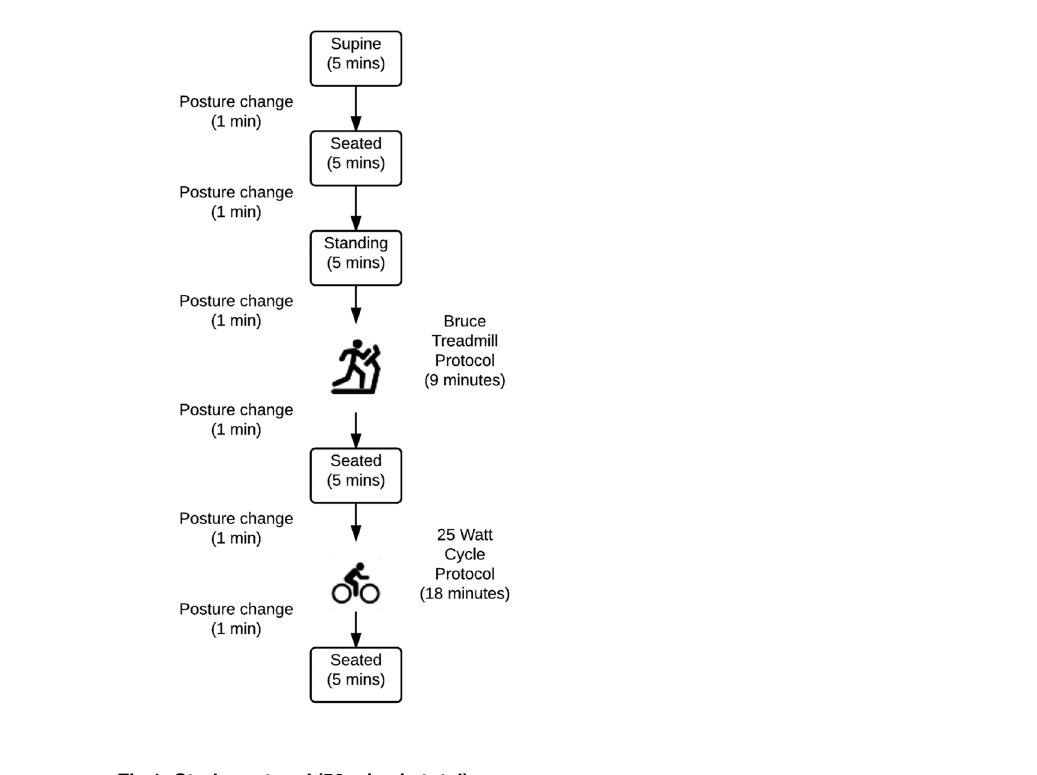
Fig 1. Study protocol (58 mins in